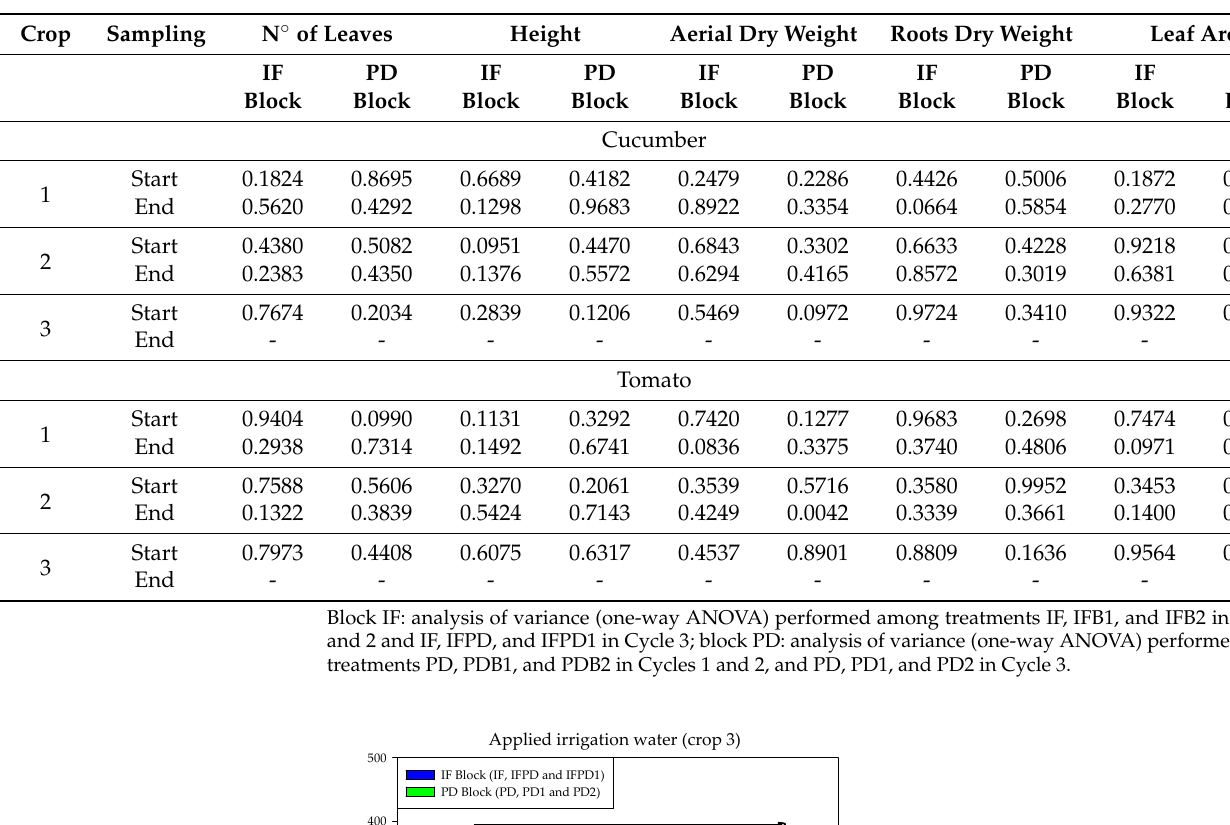
Table 8. Influence of Brassica carinata pellets (Crops 1 and 2) and tomato plant debris (Crop 3) on leaf number, height, aerial dry weight, root dry weight, and leaf area in cucumber and tomato seedlings grown in a controlled environment chamber in IF and PD blocks.